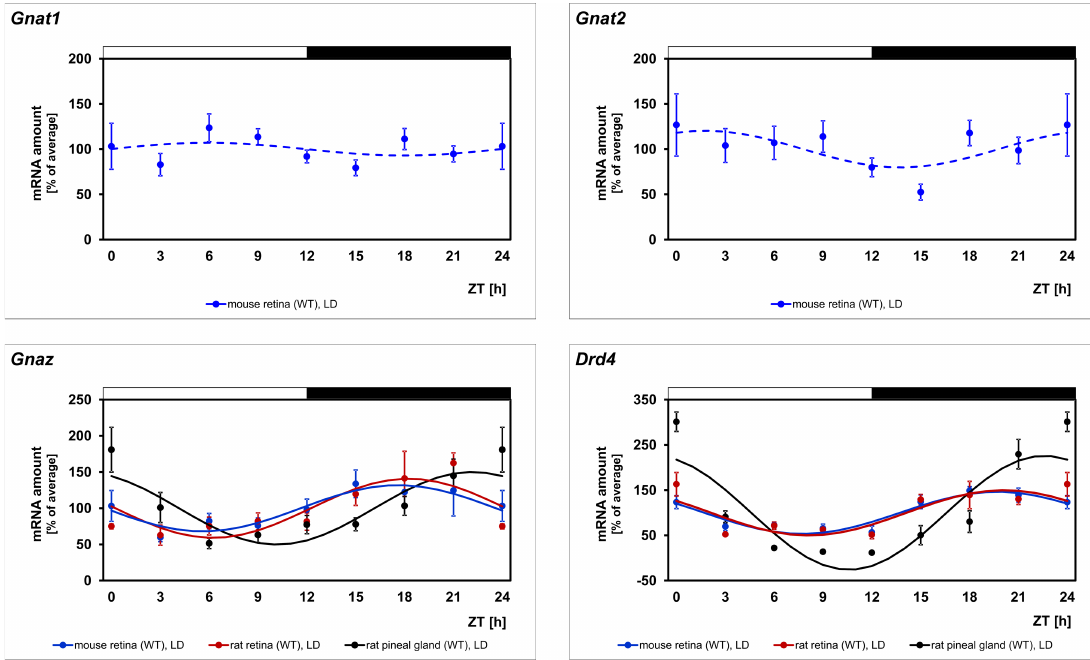
Fig 1. Daily profiling of the different types of α -transducins to be under daily regulation. Transcript levelsof the non-visual α -transducin Gnaz , the visual α -transducins Gnat1 and Gnat2 , and the geneencodingthe dopamine D 4 receptor, Drd4 ,were measuredusingqPCR under LD in mouse retina (bluelines). Gnaz and Drd4 mRNAs were also examinedin rat retina(red lines) andrat pinealgland (black lines). The mRNA levelsare plotted as a function of ZT and the lines representthe periodicsinusoidal functions determined by cosinoranalysis(solidand brokenline for p < 0.05 andp > 0.05 in cosinoranalysis).Data representa percentage of the averagevalueof the transcriptamountduringthe 24-h period.Statisticalanalysisof transcriptional profilingis provided in Table 2. The valueof ZT0 is plotted twice at both ZT0 andZT24. The solid bars indicatethe dark period.Each value represents mean ± SEM (n = 4; each n represents two retinaeand a pinealgland of one animal).Note that the mRNA levelsof exclusively Gnaz and Drd4 exhibitsignificantvariationsin all